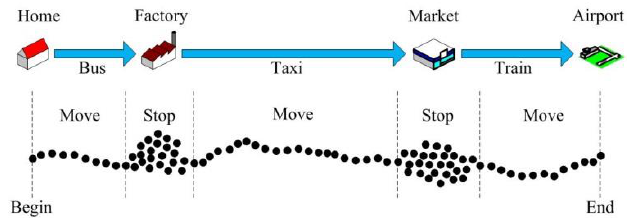
Figure 1. An example trajectory in the form of a stop–move model.